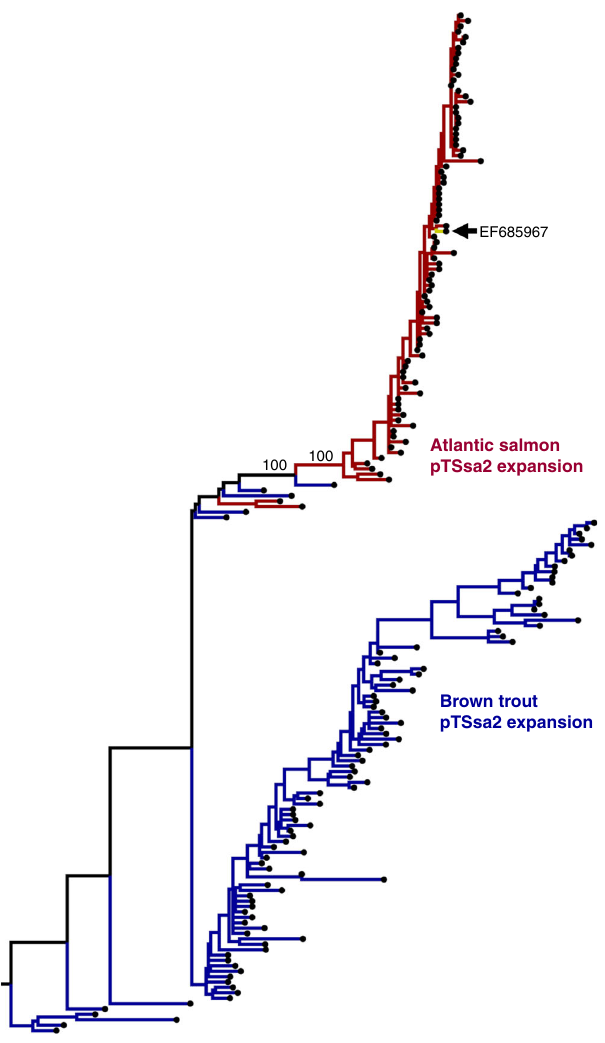
Fig. 2 Evidence for an active DNA transposon in Salmo evolution. Phylogenetic tree of Atlantic salmon sequences representing deletion polymorphisms matching the pTSsa2 piggyBac-like DNA transposon 28 (EF685967) and 100 top hits to this sequence within the brown trout genome. The tree was generated from an alignment spanning the length of pTSsa2 (Supplementary Data 8) using the TPM3 + F + G4 substitution model. Bootstrap values are given at key nodes. A full tree with sequence identi fi ers, genomic locations of pTSsa2 sequences and bootstrap values is provided in Supplementary Fig. 18. A circos plot highlighting the location of pTSsa2 sequences in the Atlantic salmon genome is given in Supplementary Fig.